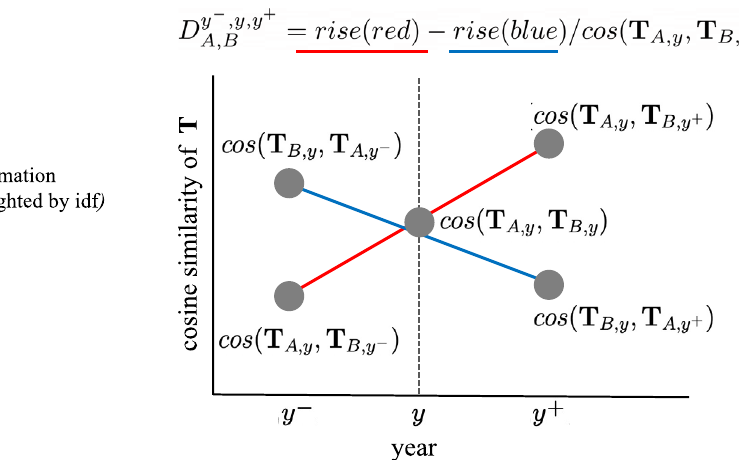
Figure 5. Calculation of Leading-Following Relationships Between Nations: ( a ) The research topic T is based on references in the papers published in a particular year. We weight each reference by using the tfidf framework. For each paper, tf ( r, p ) (the reference frequency of r in paper p) is the number of occurrences of r divided by the total number of references in the paper. We sum the values of tf for P A , y (papers published in nation A during year y), weighted by the inverse document frequency idf (as discussed in the “Methods” section). idf indicates the rarity of the references (the amount of information the reference provides) 32 . ( b ) Topic y − , y , y + progress/delay between pairs of nations: D A , B is calculated as the difference between the amount of rise of the red and blue lines. The red line indicates the extent to which nation B follows nation A (the blue line indicates the converse). In the example shown, research topics in nation A are followed by those in nation